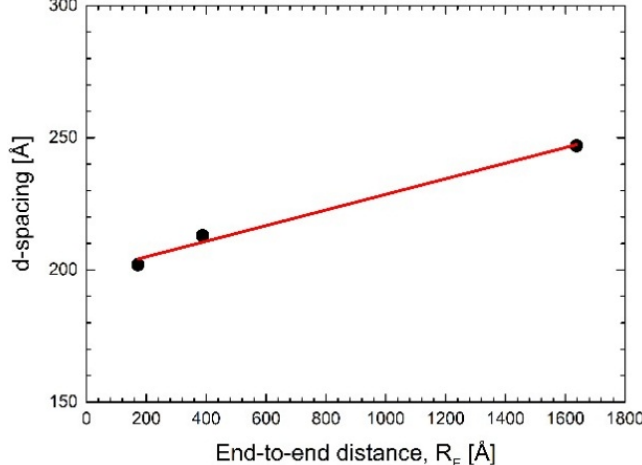
Figure 6. Measured d -spacing of the oligolamellar DMPC linings incubated in polyelectrolyte solutions at a concentration of 3 mg/mL polymer in D 2 O at 38 ˝ C plotted versus the end-to-end distance of the respective polymer ( cf. Table 3). The solid line is a linear fit to the data according to d = mR E + d 0 with m = 0.029 ˘ 0.003 and d 0 =199 ˘ 3